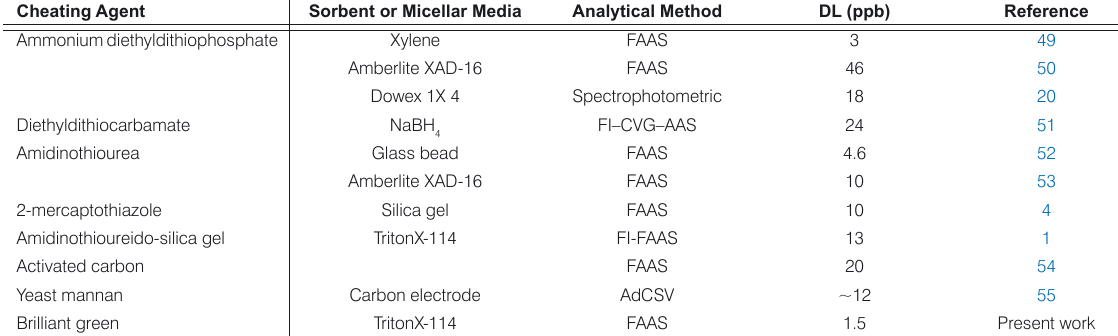
Table 3. Comparison of the present method with reported methods for the preconcentration of Au Cheating Agent